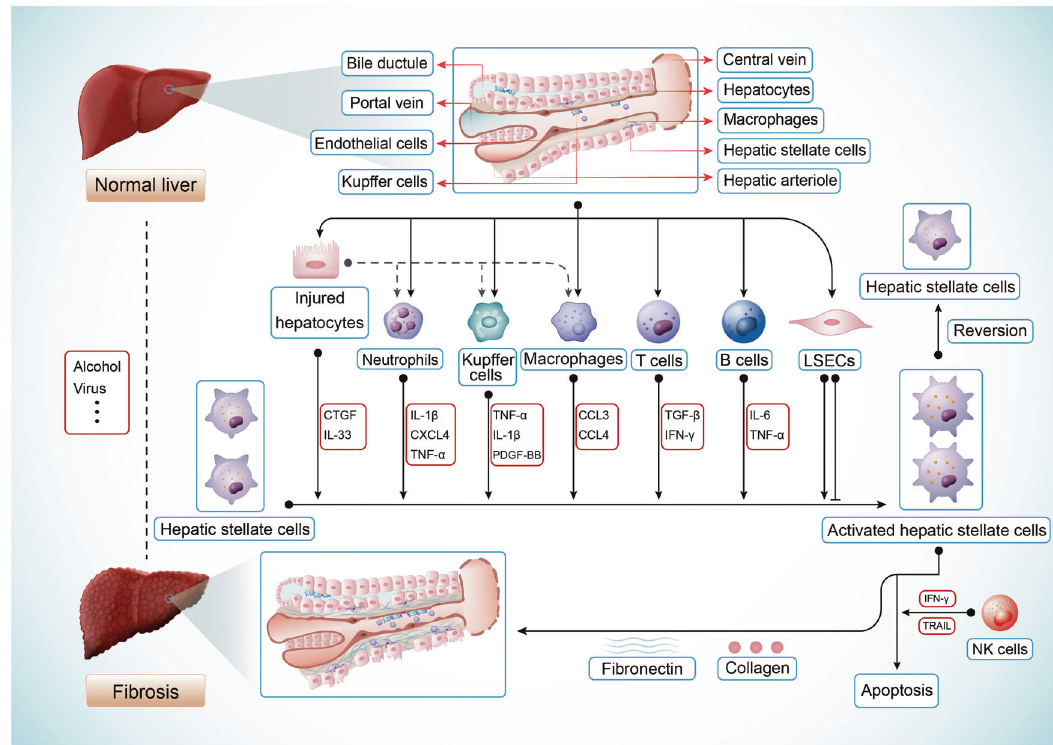
Fig. 2 The activation of HSCs regulated by other cells in liver fi brosis. Extracellular components from injured hepatocytes, Kupffer cells, macrophages, NK cells, T and B lymphocytes modulate HSCs activation via various cytokines. LSECs inhibit or promote the activation of HSCs in different conditions. NK cells kill activated HSCs in IFN γ and TRAIL-dependent ways. TRAIL, TNF-related apoptosis-inducing